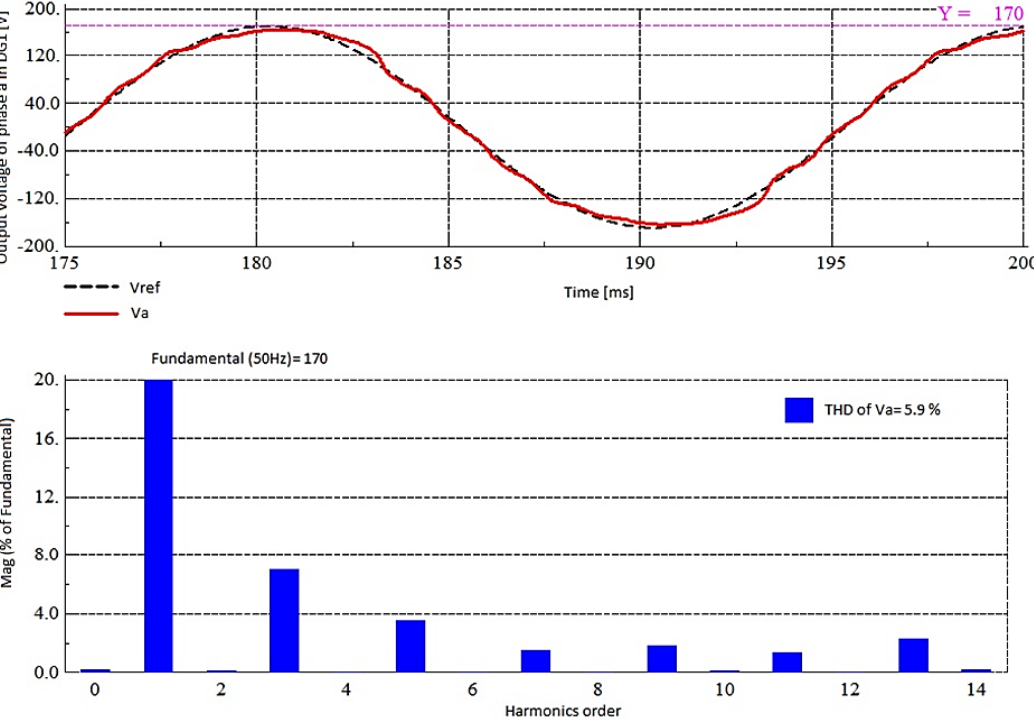
Figure 20. Output voltage of phase ‘a’ and the associated voltage harmonic spectrum, without using the harmonic compensation loop.